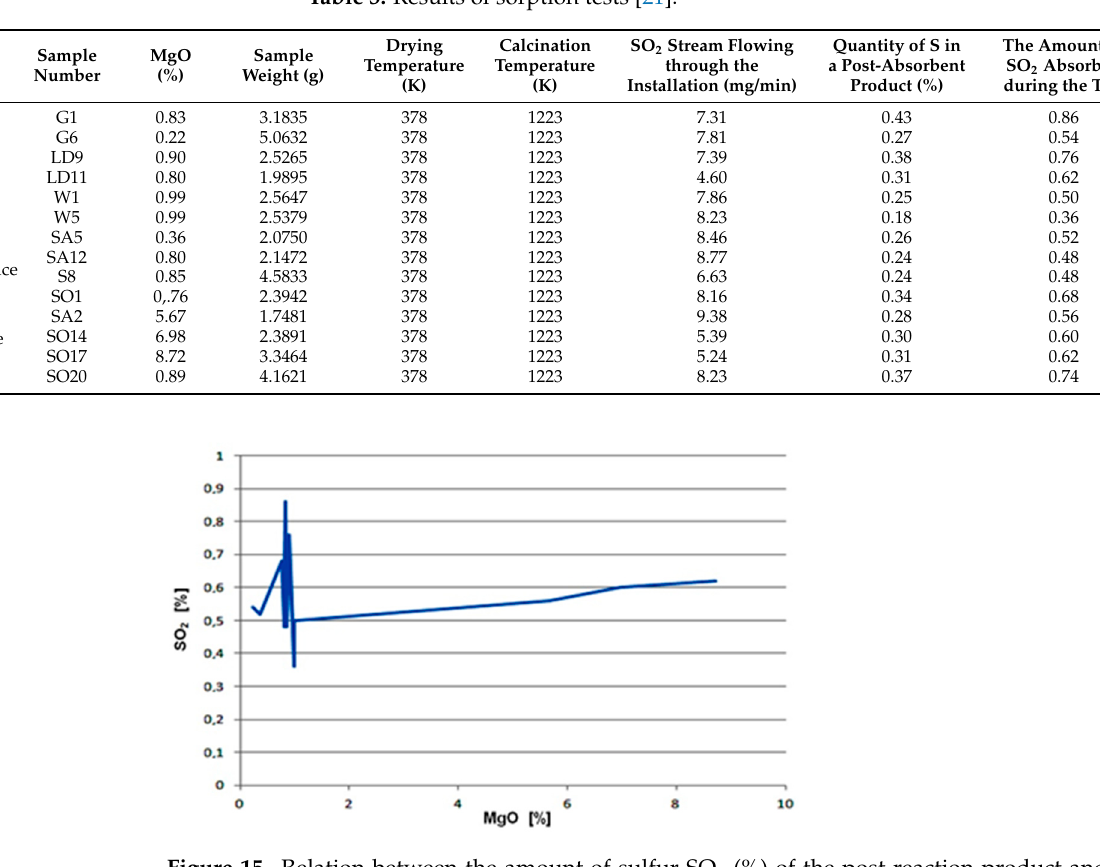
Table 3. Results of sorption tests [21].